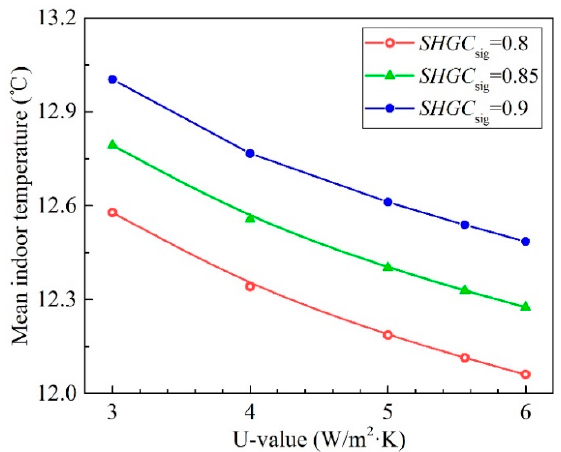
Figure 18. Mean indoor air temperature under various U-values of single-glass window.